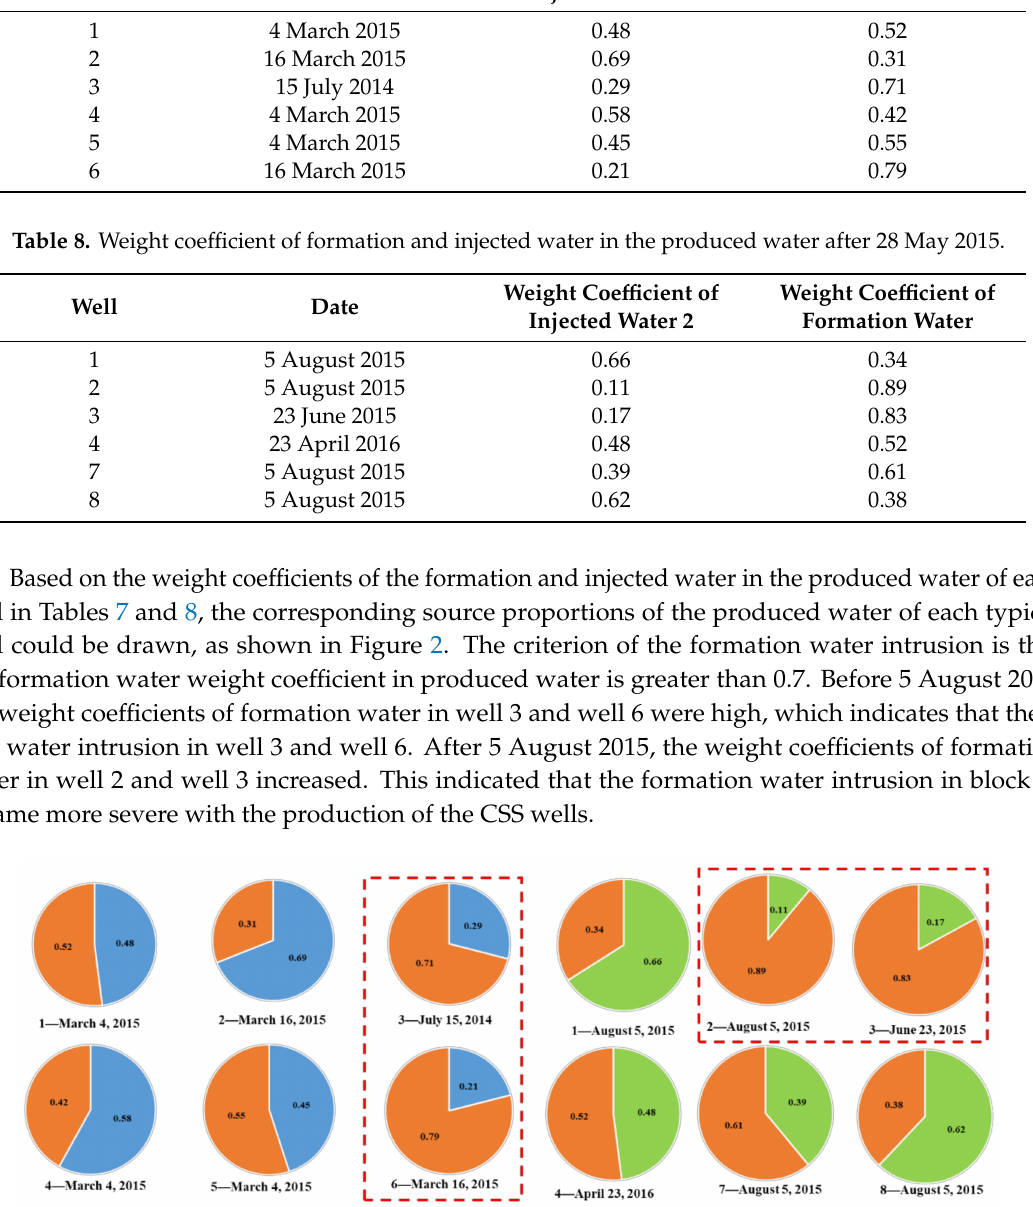
Weight Coe ffi cient of Injected Water 1